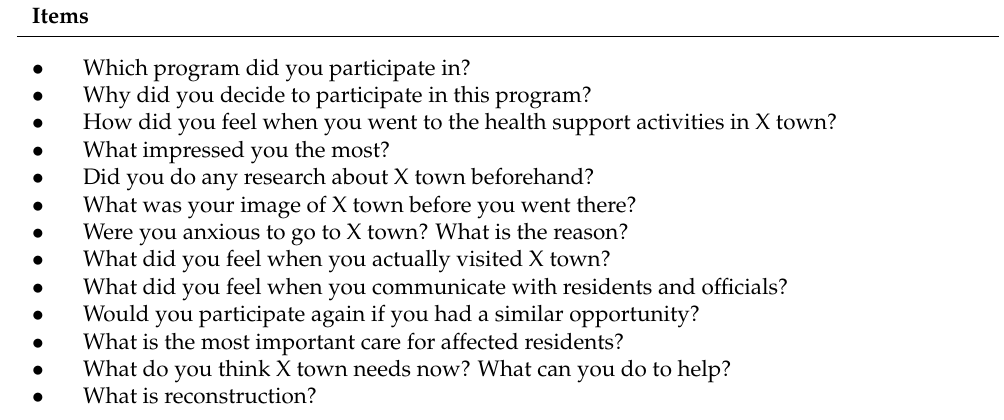
Table 2. Items of the